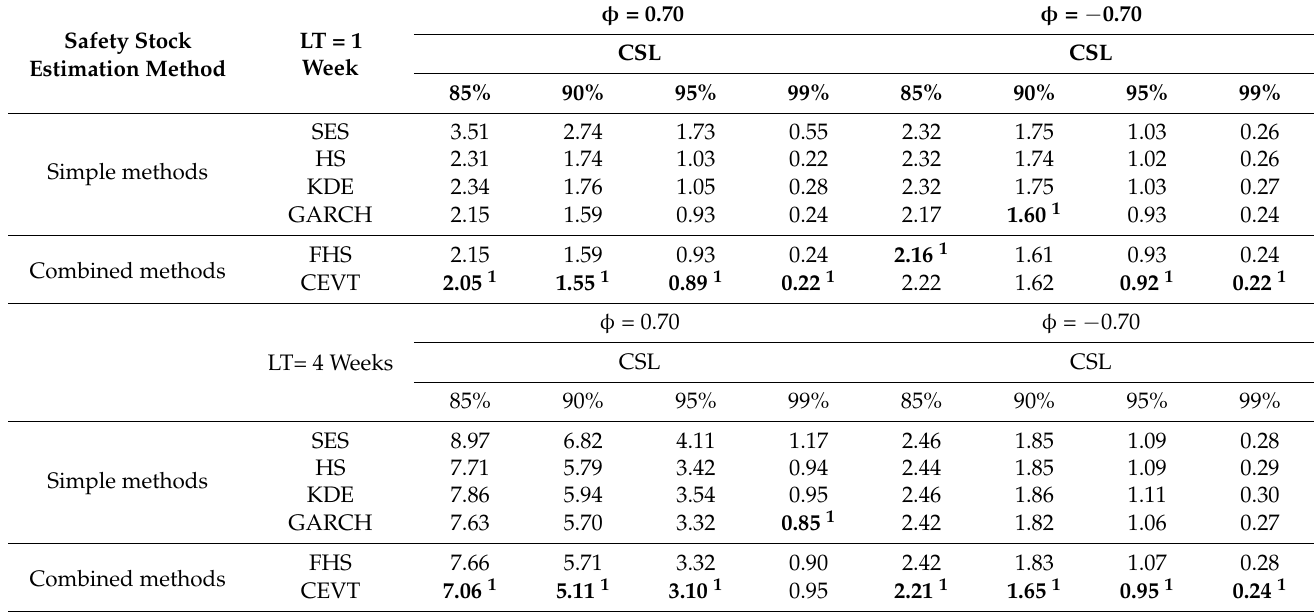
Table 1. Tick loss function values corresponding to φ = 0.70 and φ = − 0.70 when forecasting errors follow a normal distribution.